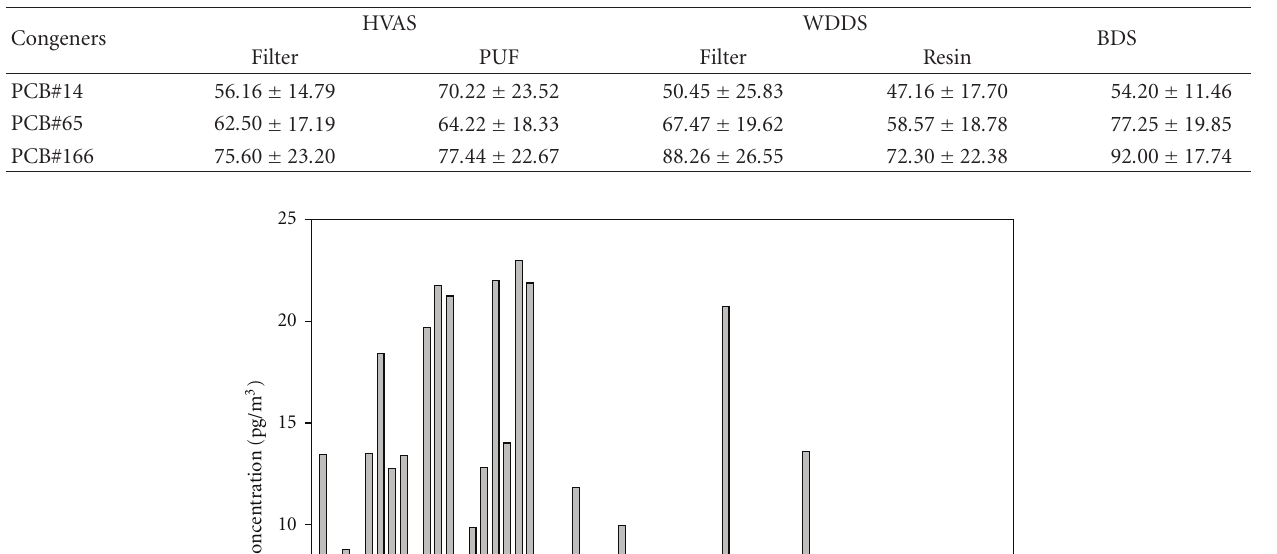
Table 2: Recovery e ffi ciencies for the HVAS and BDS samplers.